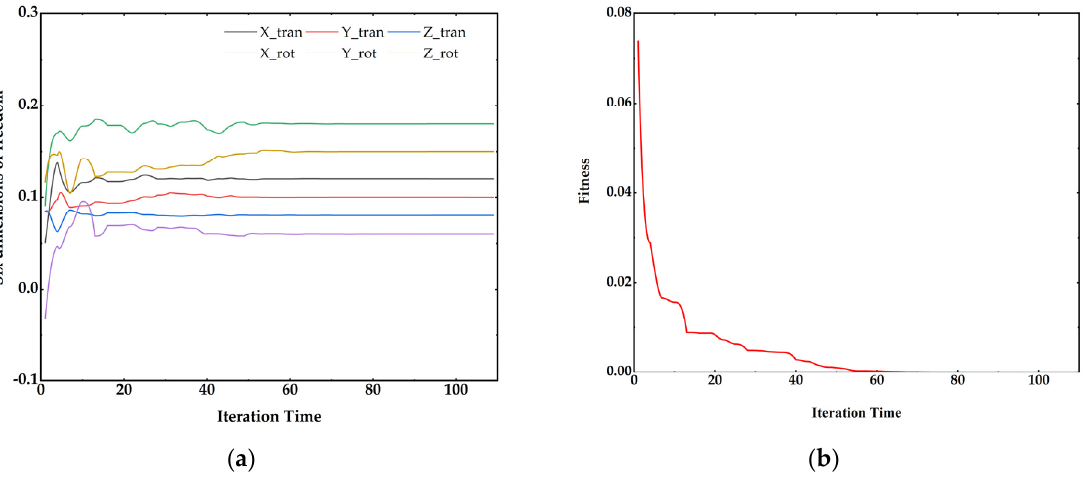
Figure 5. Convergence of Six–DOF and fitness by SA–PSO method. ( a ) Posture convergence progress with iteration. ( b ) Fitness convergence with iteration. Table 3. Error of each dimension by SA–PSO.